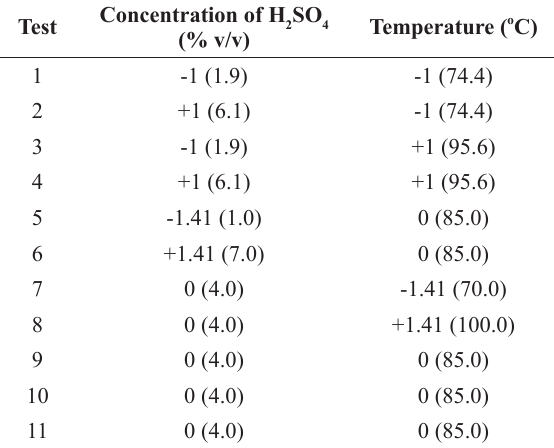
Codified levels and actual values of the variables studied in the acid hydrolysis